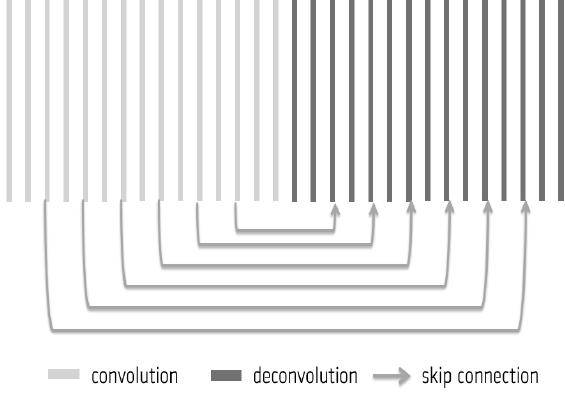
Figure 2. The overall architecture of the network (RED30).